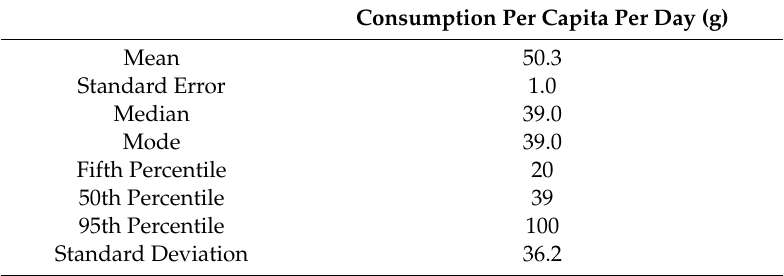
Table 3. Descriptive Statistics of Feta cheese consumption data for adults 20–65 years old according to the Hellenic National Nutrition & Health Survey (HNNHS)